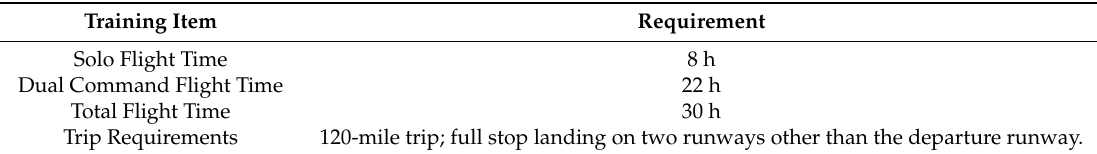
Table A2. Practical training requirements for Portuguese ultralight